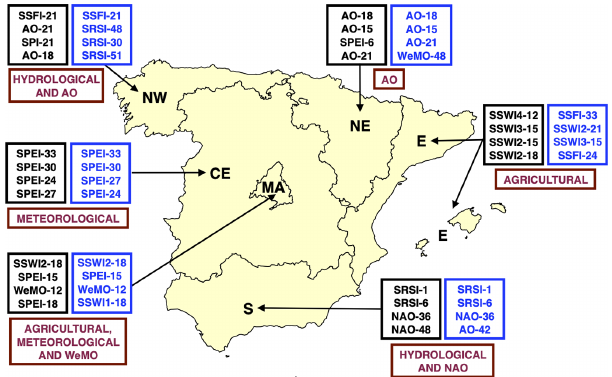
Figure 10. Map with the top four predictors for each sub-region when using the regression random forest models and the two most censoring counting methods, in blue and black, respectively. The best type of predictors for each sub-region are in